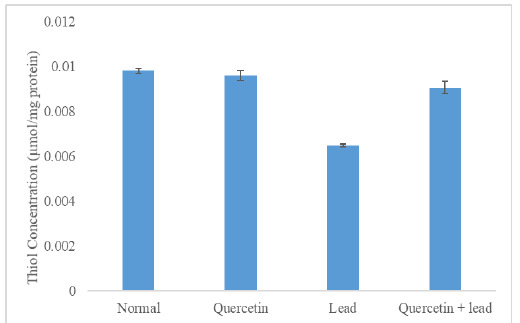
Figure 2. Effects of Quercetin on Total Thiol Concentration in Lead Treated Drosophila.* = significant is when compared to normal control group.